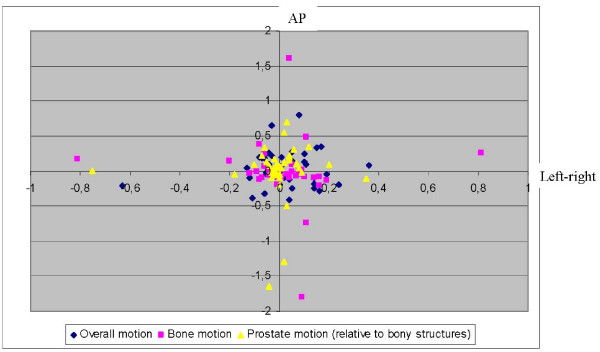
Overall intrafraction motion vs bony displacement only vs soft tissue displacement. Overall intrafraction motion (blue); bony displacement only (pink) and displacement of the sof tissue structures relative to the bony anatomy (yellow) on a patient-to-patient basis in × (left-right; abscissa) and z (AP; ordinate) directions.